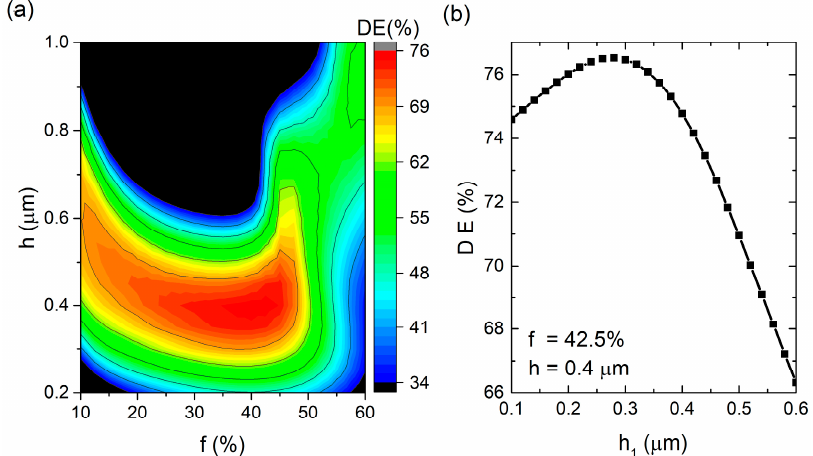
Figure 3. ( a ) Calculated GaP diffraction efficiency (DE) as a function of groove depth h and filling factor f , with h 1 =360 nm thick SiO 2 ARC, and ( b ) diffraction efficiency (DE) versus SiO 2 ARC thickness ( h ) , at λ p = 2.06 µ m, d = 1.7 µ m, and 3 THz phase-matching 1